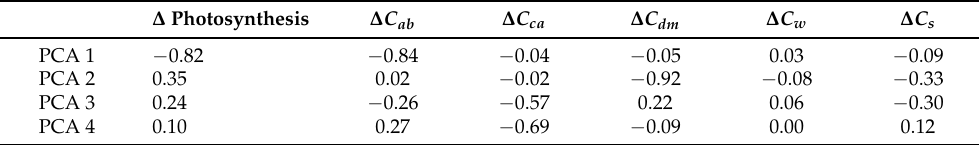
Table 2. Pearson’s correlation coefficients between the PCA component amplitudes of the Compound Ratio spectra calculated from the SCOPE simulated apparent reflectances and relative changes in the various vegetation health indicators: photosynthesis rates, chlorophyll AB content ( C ab ), carotenoid content ( C ca ), dry matter content ( C dm ), leaf water equivalent layer ( C w ), and senescent material fraction ( C s ). ∆